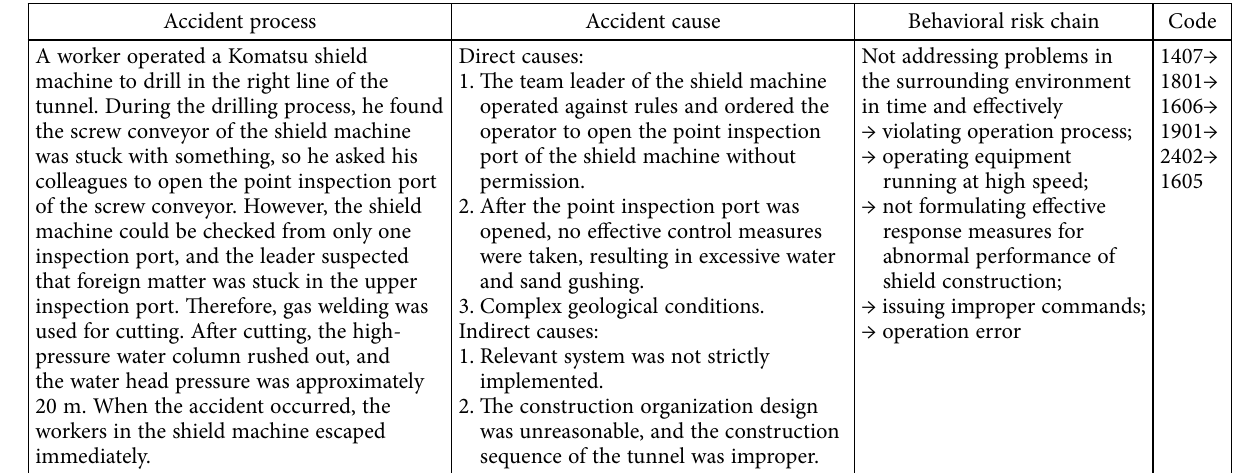
Table 2. An example of behavioral risk chain